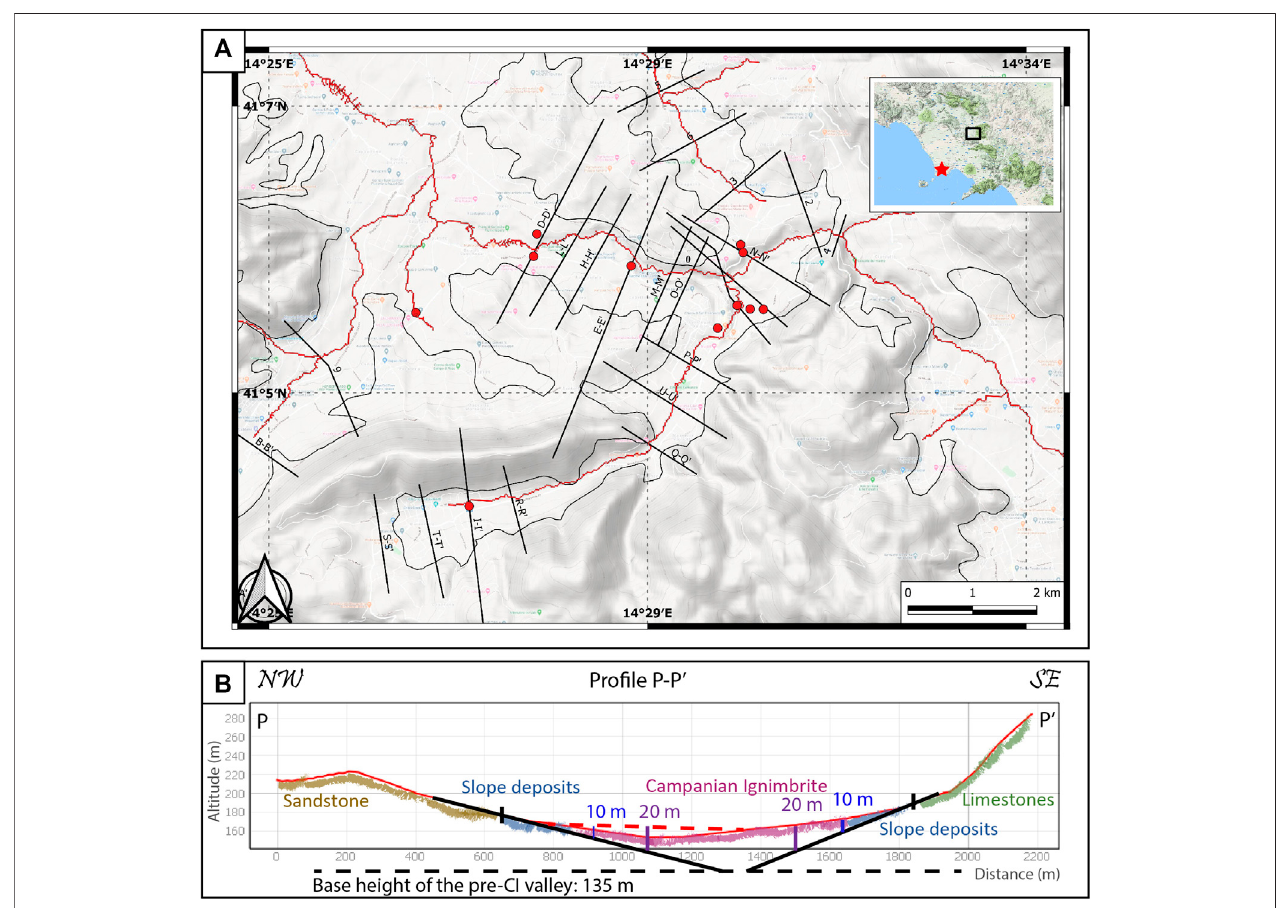
FIGURE 2 | The topographic reconstruction in the Sant ’ Agata dei Goti area (reported in the right corner, the red star is the vent). (A) A series of pro fi les traced to study the paleo-valley; the red dots are the studied outcrops where the Campanian Ignimbrite (CI) is exposed. The red lines represent the river network developed through the QGIS software, while the black line is the 0 m isopach. (B) Reconstruction of the paleo-valley in pro fi le P-P ’ , the base elevation is constrained to the CI base observed by fi eldwork and to the current slope of the valley. The resulting thickness is coherent with fi eldwork, so where thicknesses are too high, they were not considered and the isopachs were traced up to a realistic thickness. The numbers represent the thickness of the CI in meters. The different colors represent different types of deposits, while the dashed red line, is the linear erosion that occurred in 39 kyrs.